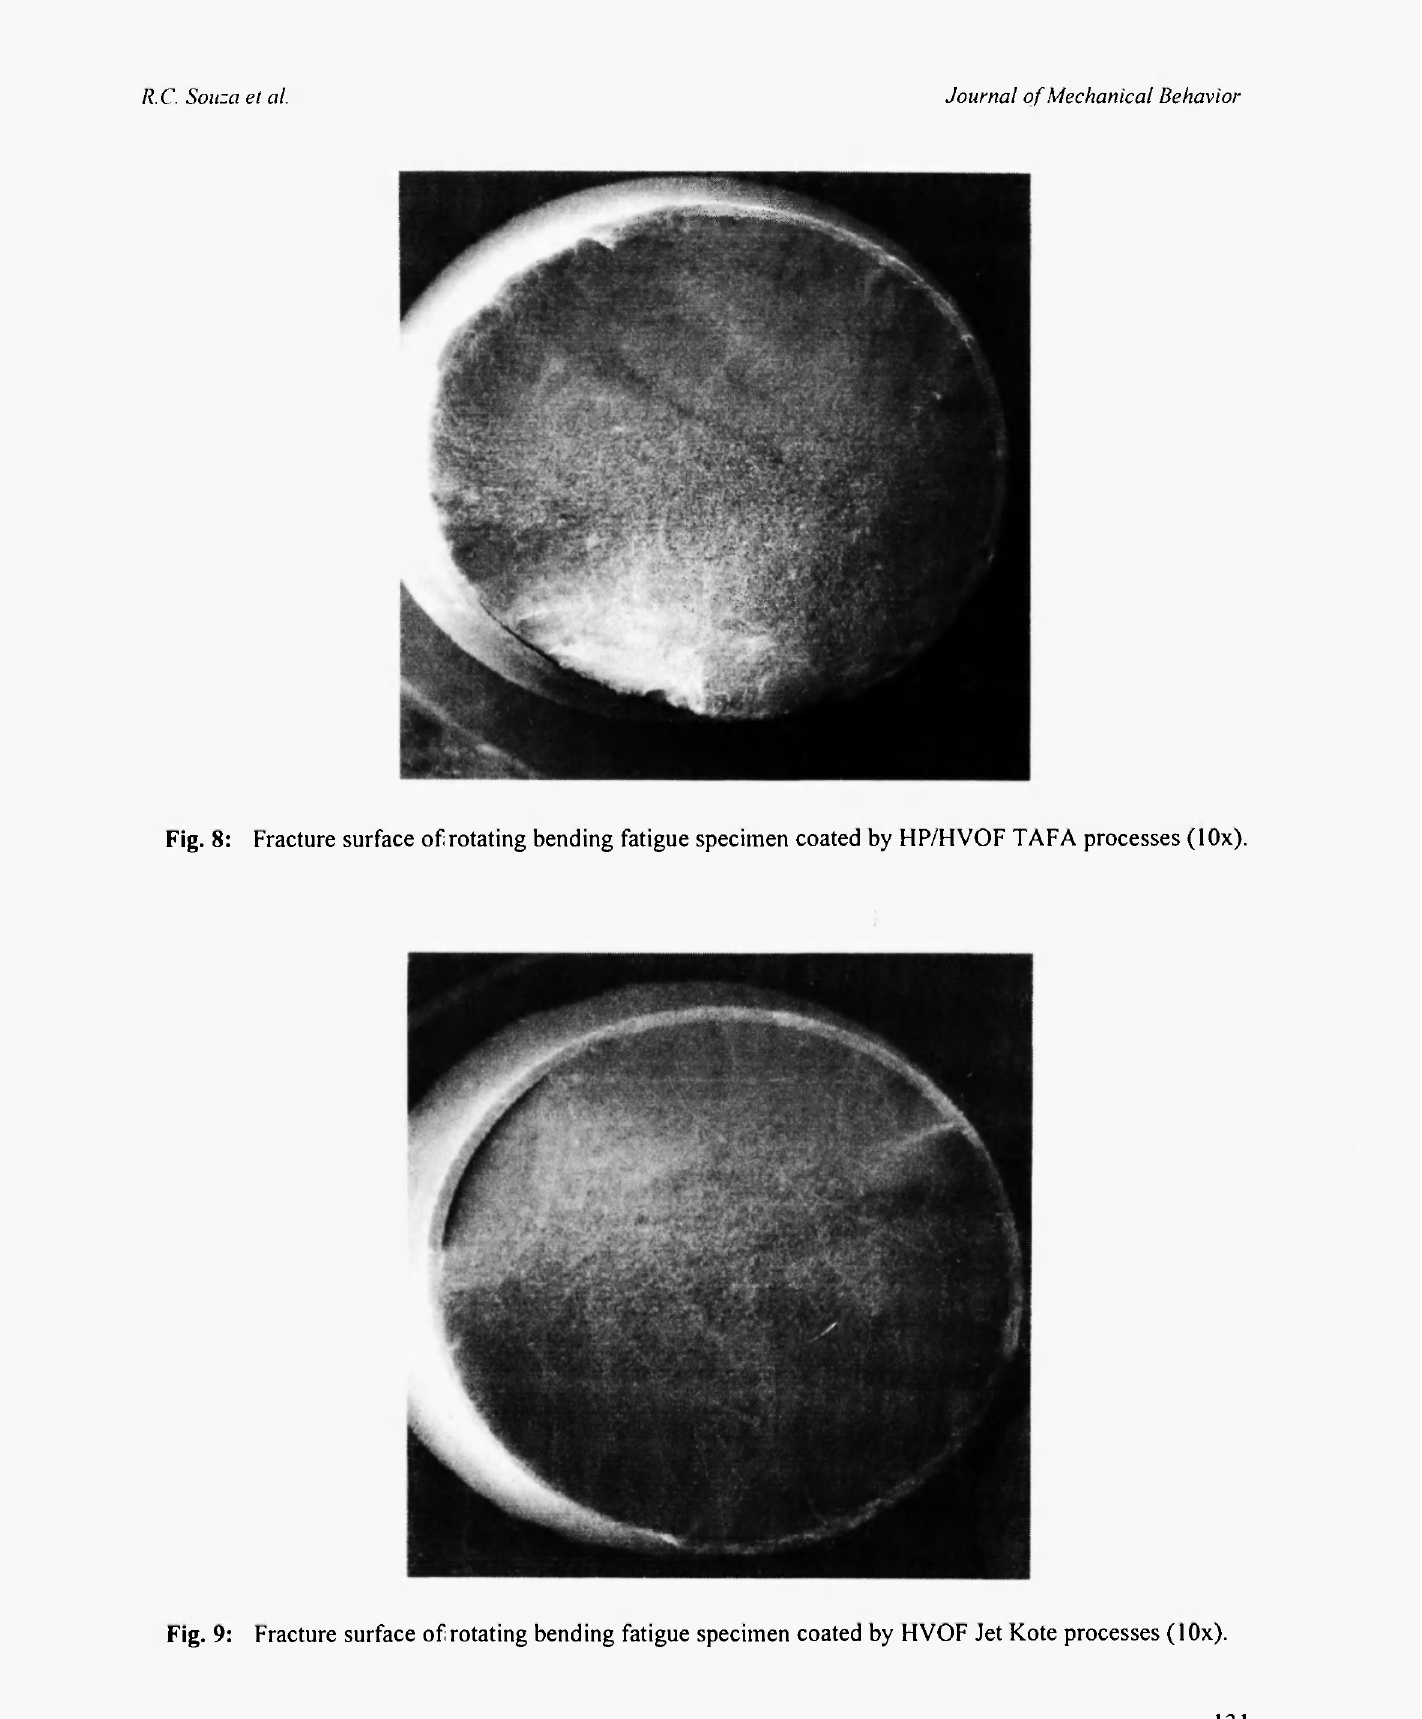
Fig. 9: Fracture surface of rotating bending fatigue specimen coated by HVOF Jet Kote processes